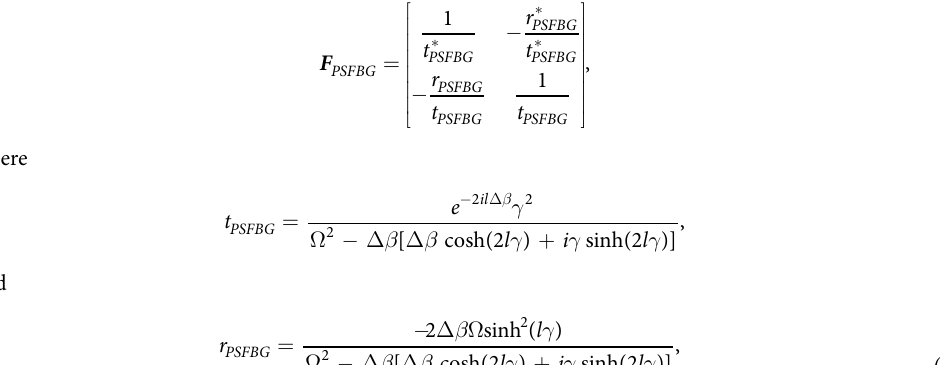
coupling efficiency between two counter propagating waves, here Δ n 0 is the refractive index modulation ampli- tude of Bragg grating, Γ is the confinement factor relative to the ratio of guided energy in the core of fiber, and ν